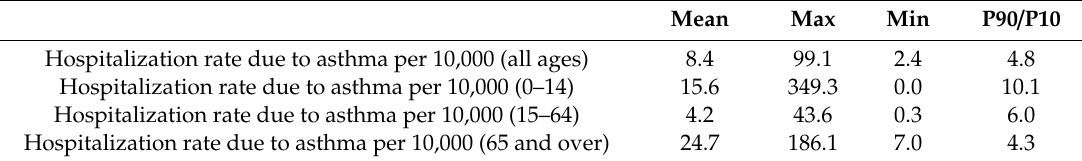
Table 1. Variation statistics of hospitalization rates for asthma by age group.